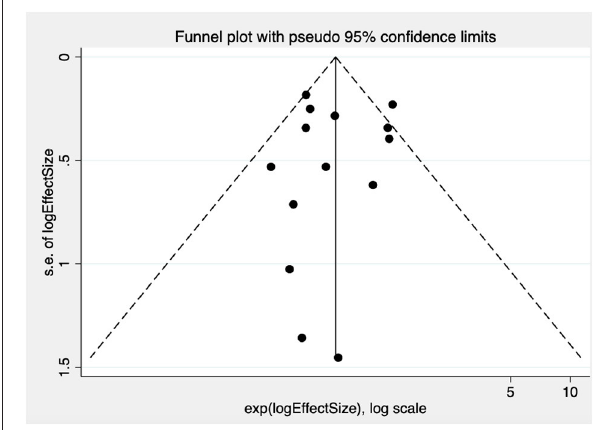
FIGURE 3 | Funnel plot test for publication bias in studies examining risk of AF in patients with PFO compared with those without. Treatment effect is on the x -axis, measure of study size on the y -axis. s.e. indicates standard